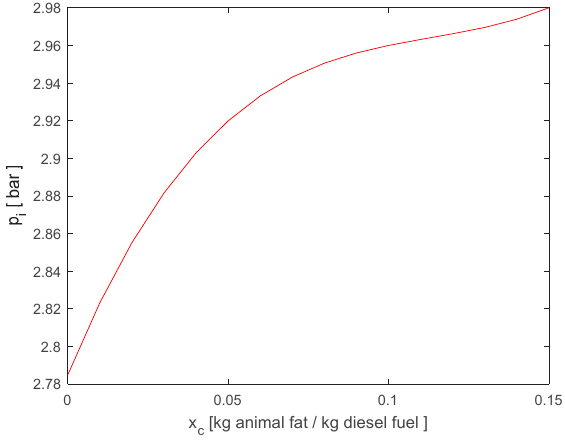
Figure 12. Indicated mean effective pressure variation for different x c , at variable engine setup parameters.